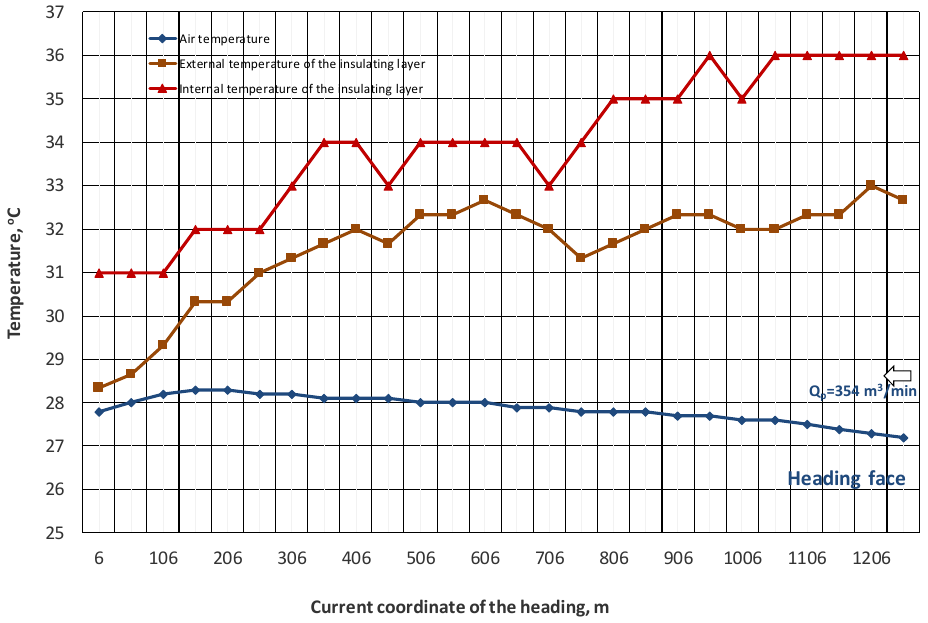
Figure 5. Temperature distribution around the perimeter of the excavation and behind the insulating foam layer in the driven Pilot Roadway 7 in coal seam 409—measurement series on 16 October (before breaking the heading and obtaining a through-flow ventilation).